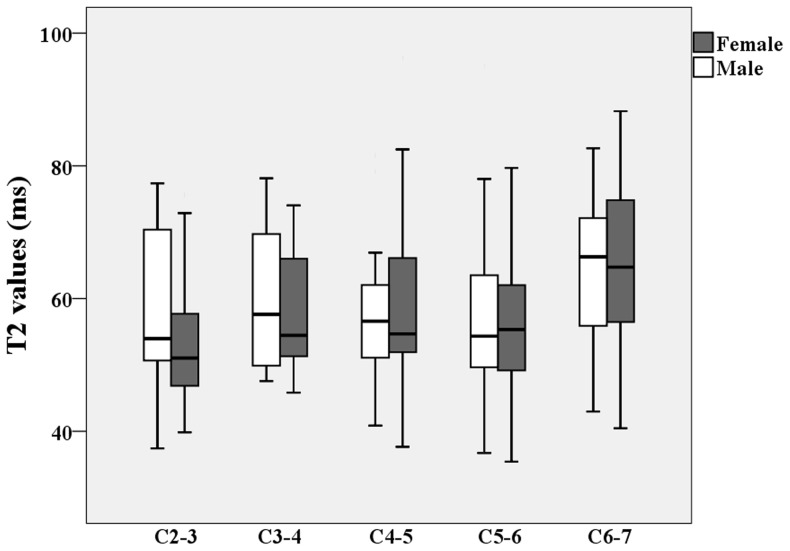
Box plots of T2 value of nucleus pulposus (NP) by sex according to the anatomic level of each disc.White: Male; Black: Female. The boxes represent the median and the interquartile range, with the vertical lines showing the range.